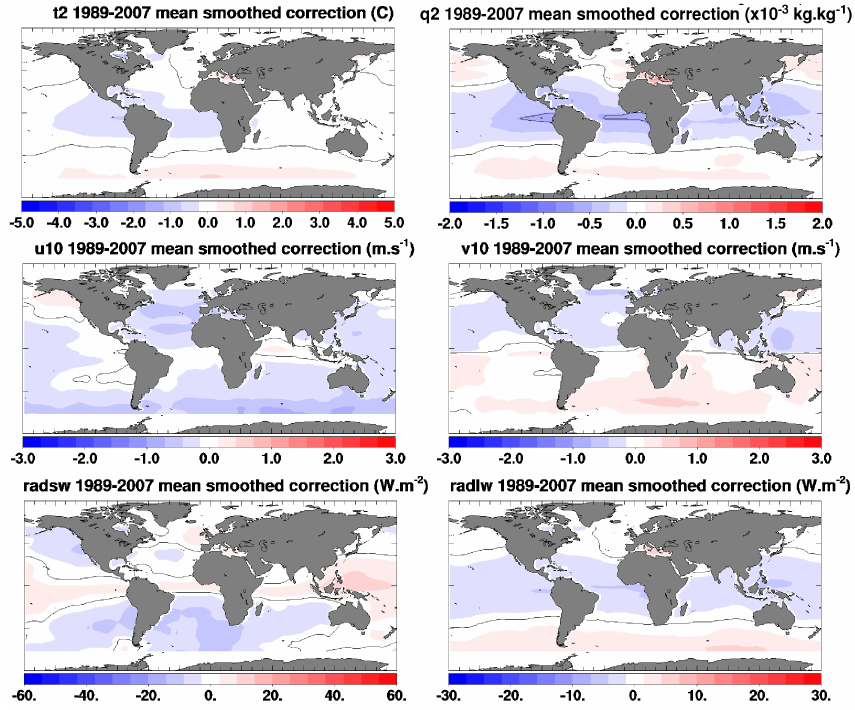
Fig. 9. 1989–2007 mean corrections of temperature ( t 2 ), humidity ( q 2 ), zonal wind speed ( u 10 ), meridional wind speed ( v 10 ), downward shortwave radiation (rad sw ), and downward long-wave radiation (rad lw ) after anisotropic boxcar smoothing and masking high latitudes values.